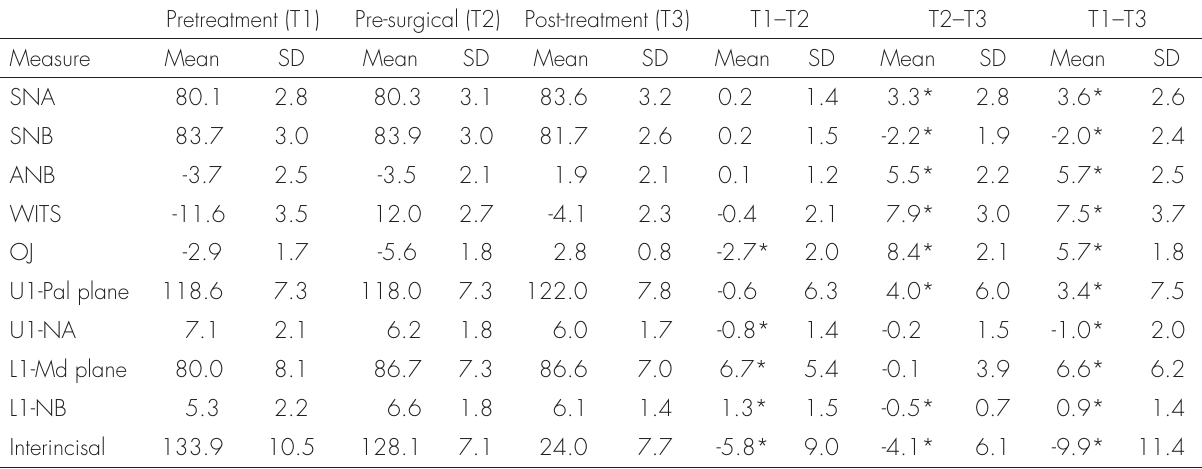
* Statistically significant difference between time points, p <